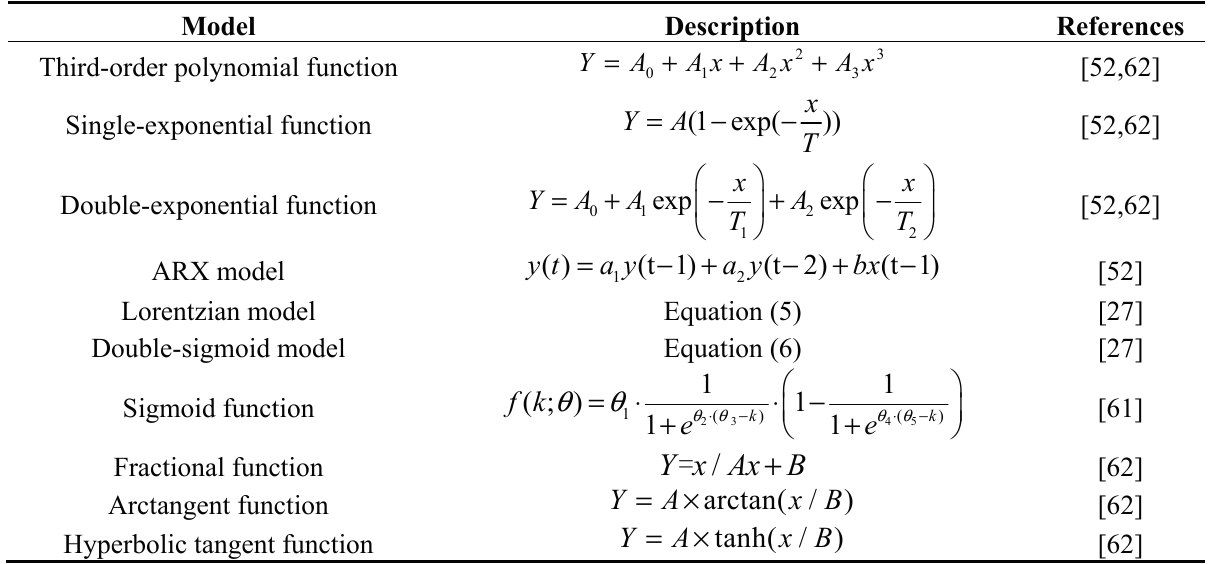
Table 9. Summary of common used curve fitting